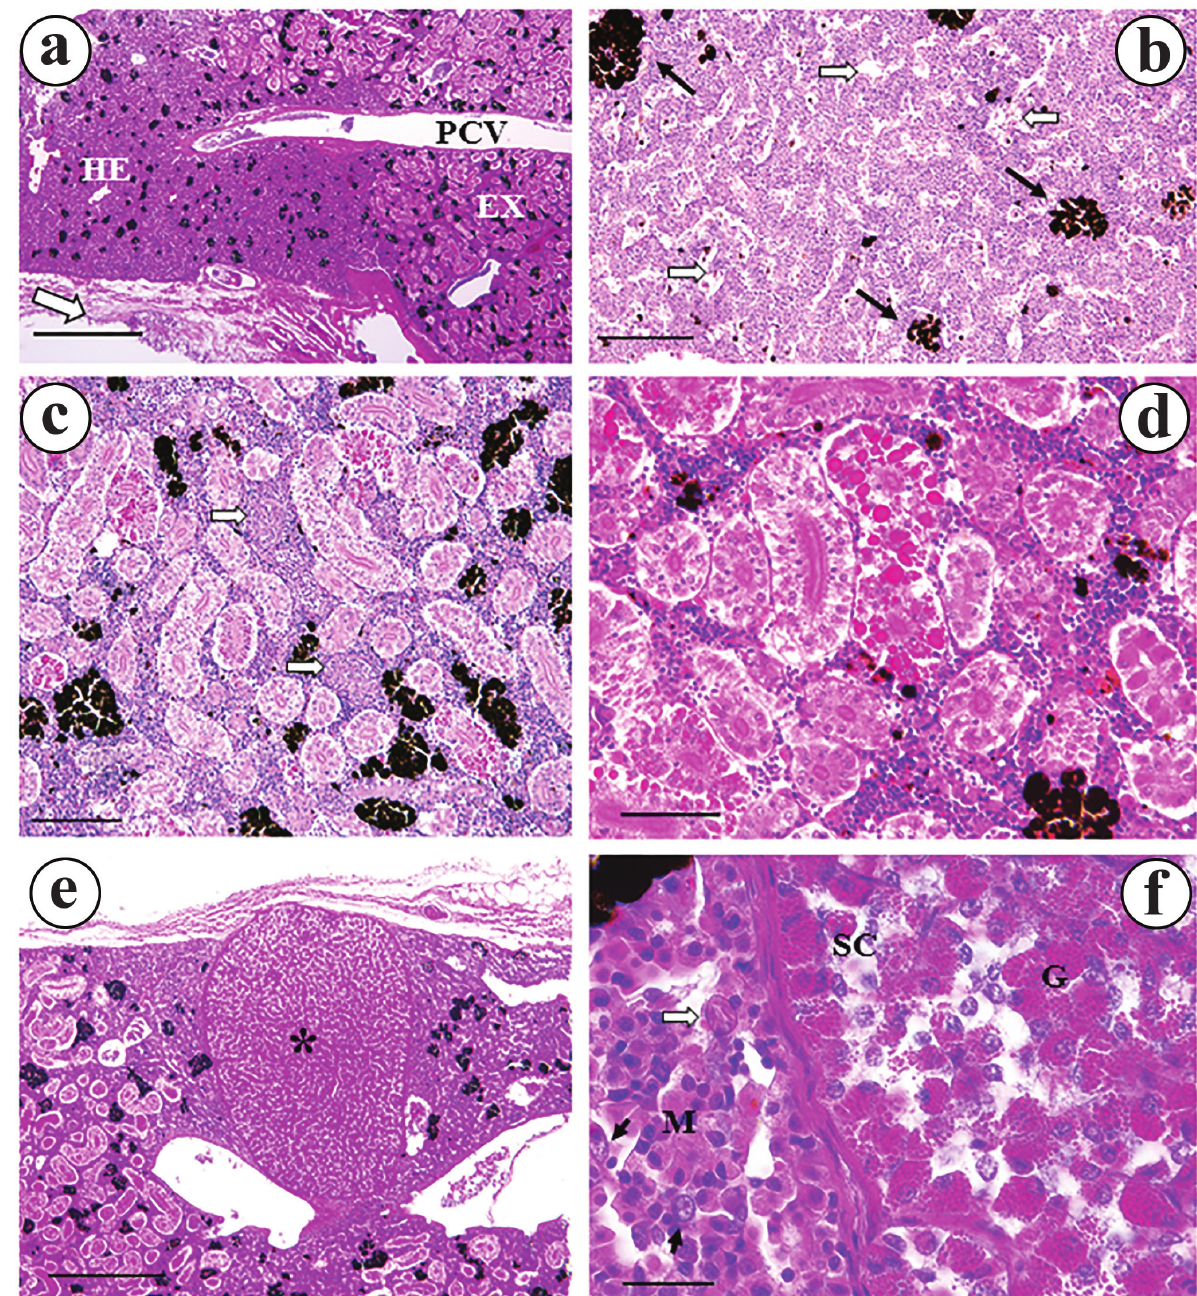
Fig. 2. Cross-section of the head and exocrine kidney in Gymnotus inaequilabiatus . a. a transitional area between head (HE) and exocrine kidney (EX) drained by postcardinal vein (PCV). Lymphohematopoietic tissue is abundant in the head portion. MMCs are diffusely distributed in both portions. A thick fibrous capsule covers the organ (white arrow); HE, bar scale = 500 µm. b. the general aspect of the head kidney. Vascular sinusoids (white arrows) surrounding the lymphohematopoietic tissue enclosing the MMCs (black arrow); HE, bar scale = 200 µm. c. interstitial lymphohematopoietic tissue with MMCs deposits characterizes the exocrine kidney, in addition, the contoured tubules; renal corpuscle (white arrow); HE, bar scale = 200 µm. d. the exocrine kidney with a proximal convoluted tubule showing hyaline degeneration of the tubular epithelium often found in this species; HE, bar scale = 100 µm. e. exocrine kidney showing the corpuscle of Stannius (*). This structure is not lobulated, and is delimited by a fibrous capsule, and situated at the junction between head and exocrine portions; HE, bar scale = 500 µm. f. detail of junction between lymphohematopoietic tissue and corpuscle of Stannius in the head kidney. Fiber bundles subdivide both structures. Rodlet cells (white arrow), macrophages (M) and eosinophilic granulocytic cells (black arrow); granulocytic (G) and secretory cells (SC) internally fill the corpuscle; HE, bar scale = 50